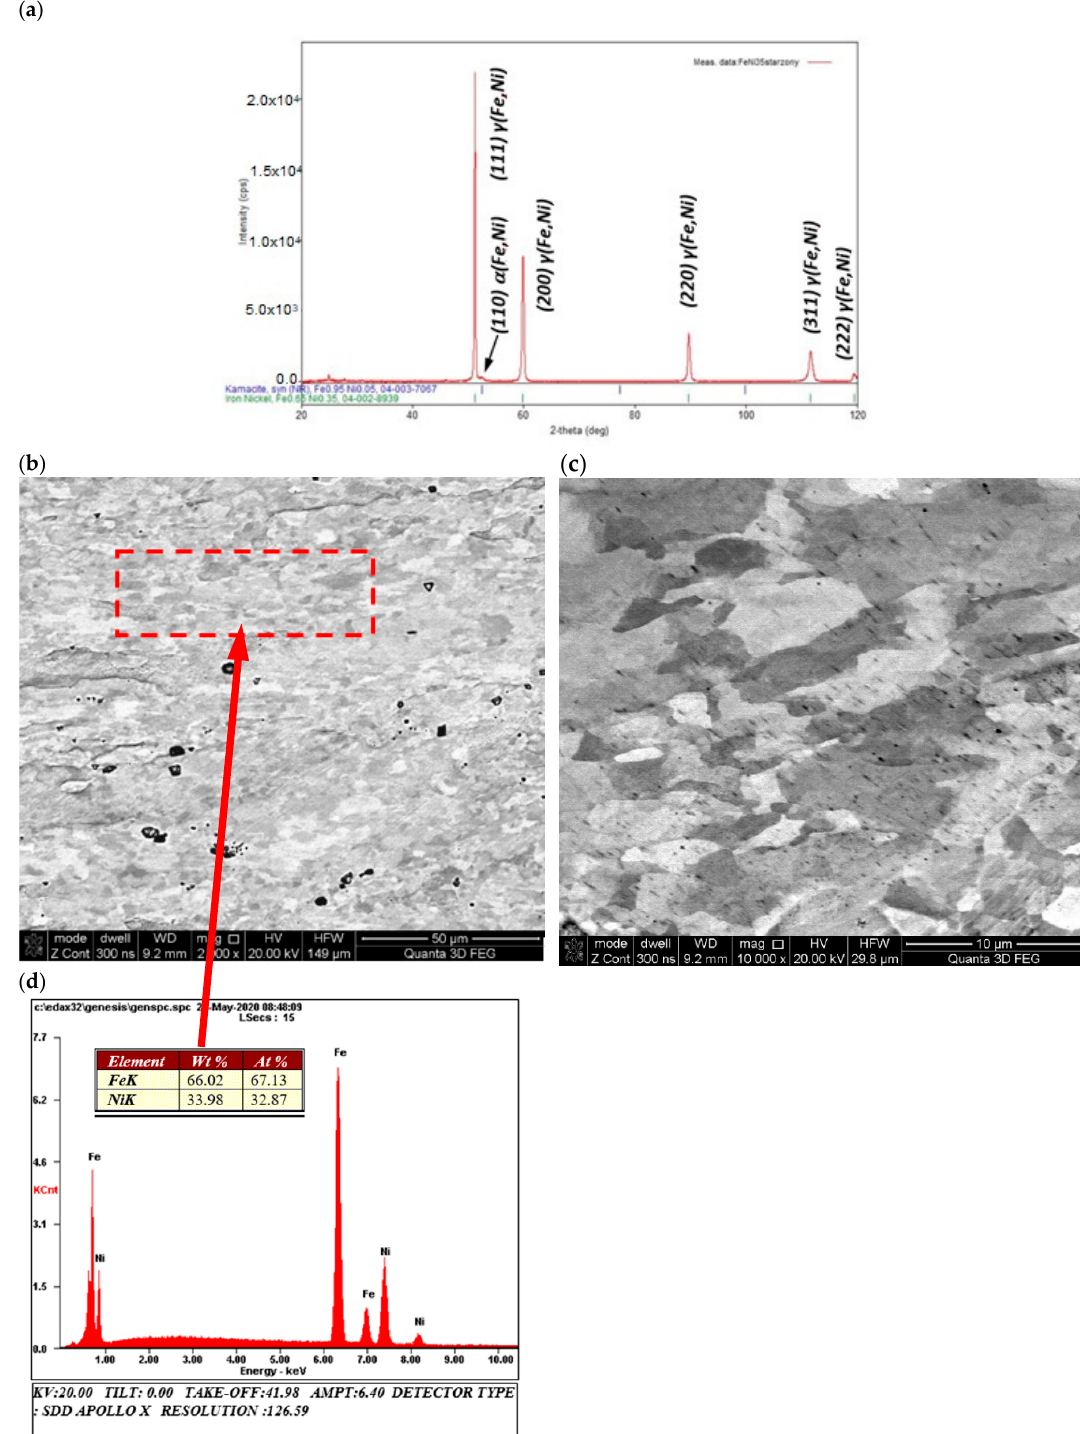
Figure 4. ( a ) X-ray diffraction (XRD) patterns of the austenitic γ (Fe, Ni) with trace amounts of ferrite α (Fe, Ni) structure of the Fe65Ni35 sample ( b ) before thermal-diffusivity tests characterized by (SEM/BSE) ( c ) homogeneous morphology of fine-grained structure (SEM/BSE), and ( d ) microanalysis results of chemical composition from area marked in ( b ).